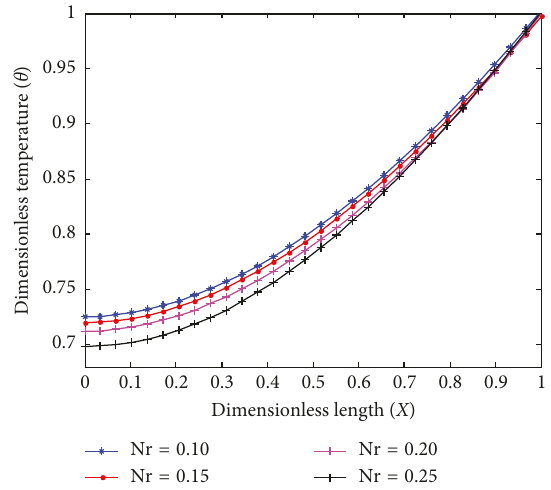
Figure 7: Effects of the radiation number on the temperature distribution.